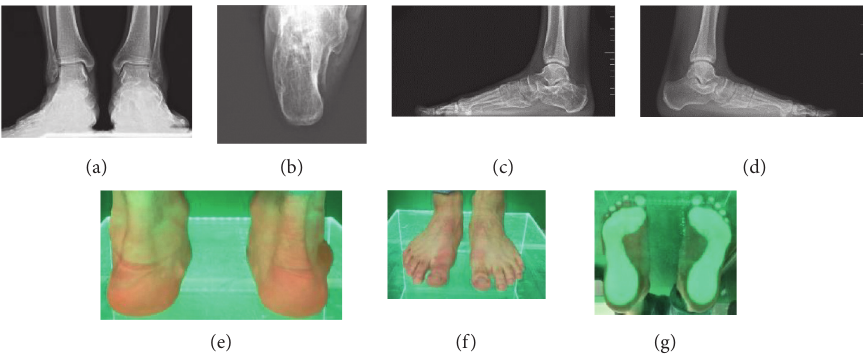
Figure 6: (a–g) Results of imaging tests (X-ray) and podoscopic tests: patient no. 7. (a) Anterior-posterior X-ray, numerous overload changes in the upper ankle joints, tarsometatarsal joints, and calcifications. (b) Axial X-ray: heel bone fracture. (c) Lateral X-ray: numerous overload changes and calcifications. (d) Lateral X-ray: numerous overload changes and calcifications. (e) Posterior photo: ankle joint and hindfoot evaluation. (f) Anterior picture of the feet: assessment of toe positioning and deformation. (g) Plantar photo on the podoscope: assessment of plantar part of the foot and height measurement of the longitudinal arch.